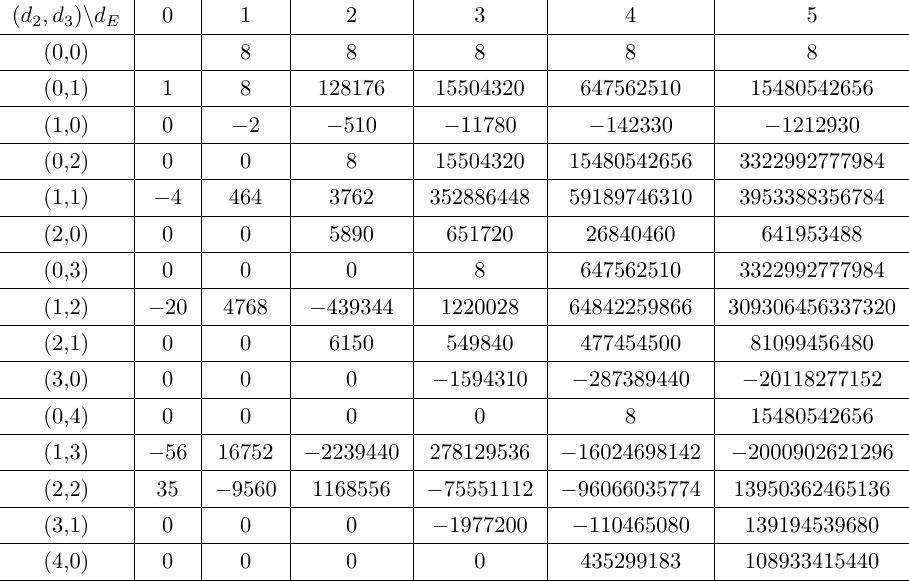
Table 14 . The refined GV numbers n g L ,g R